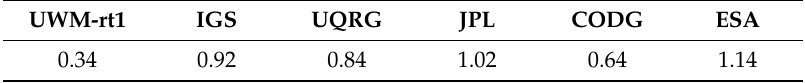
Table 2. The overall RMS based on all analyzed days, stations and satellite arcs (TECU).